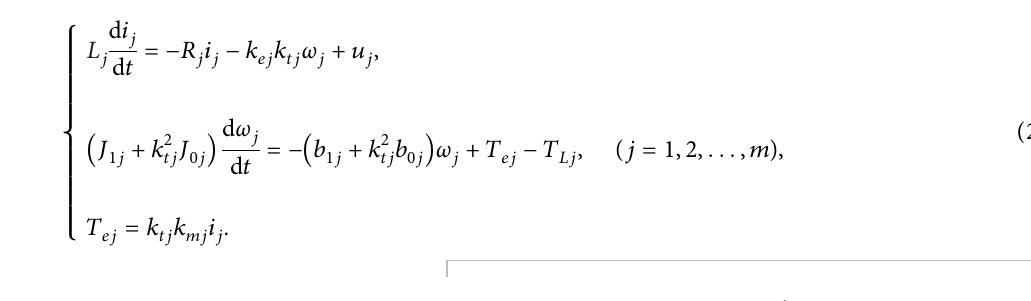
Figure 2: Schematic diagram of the DC permanent magnet motor with gearhead (reproduced from F. Beltran-Carbajal et al.’s “An asymptotic differentiation approach of signals in velocity tracking control of DC motors”, Electric Power Systems Research, 2015 (122) 218–223, Under the Creative Commons Attribution License/public